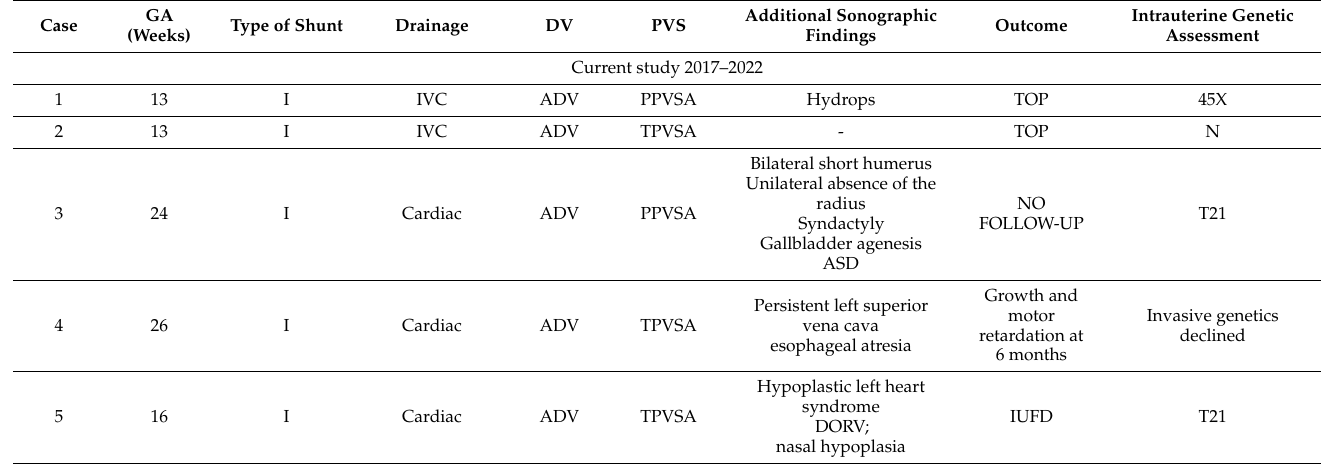
Table 1. Sonographic findings and outcomes of 31 UPSVS